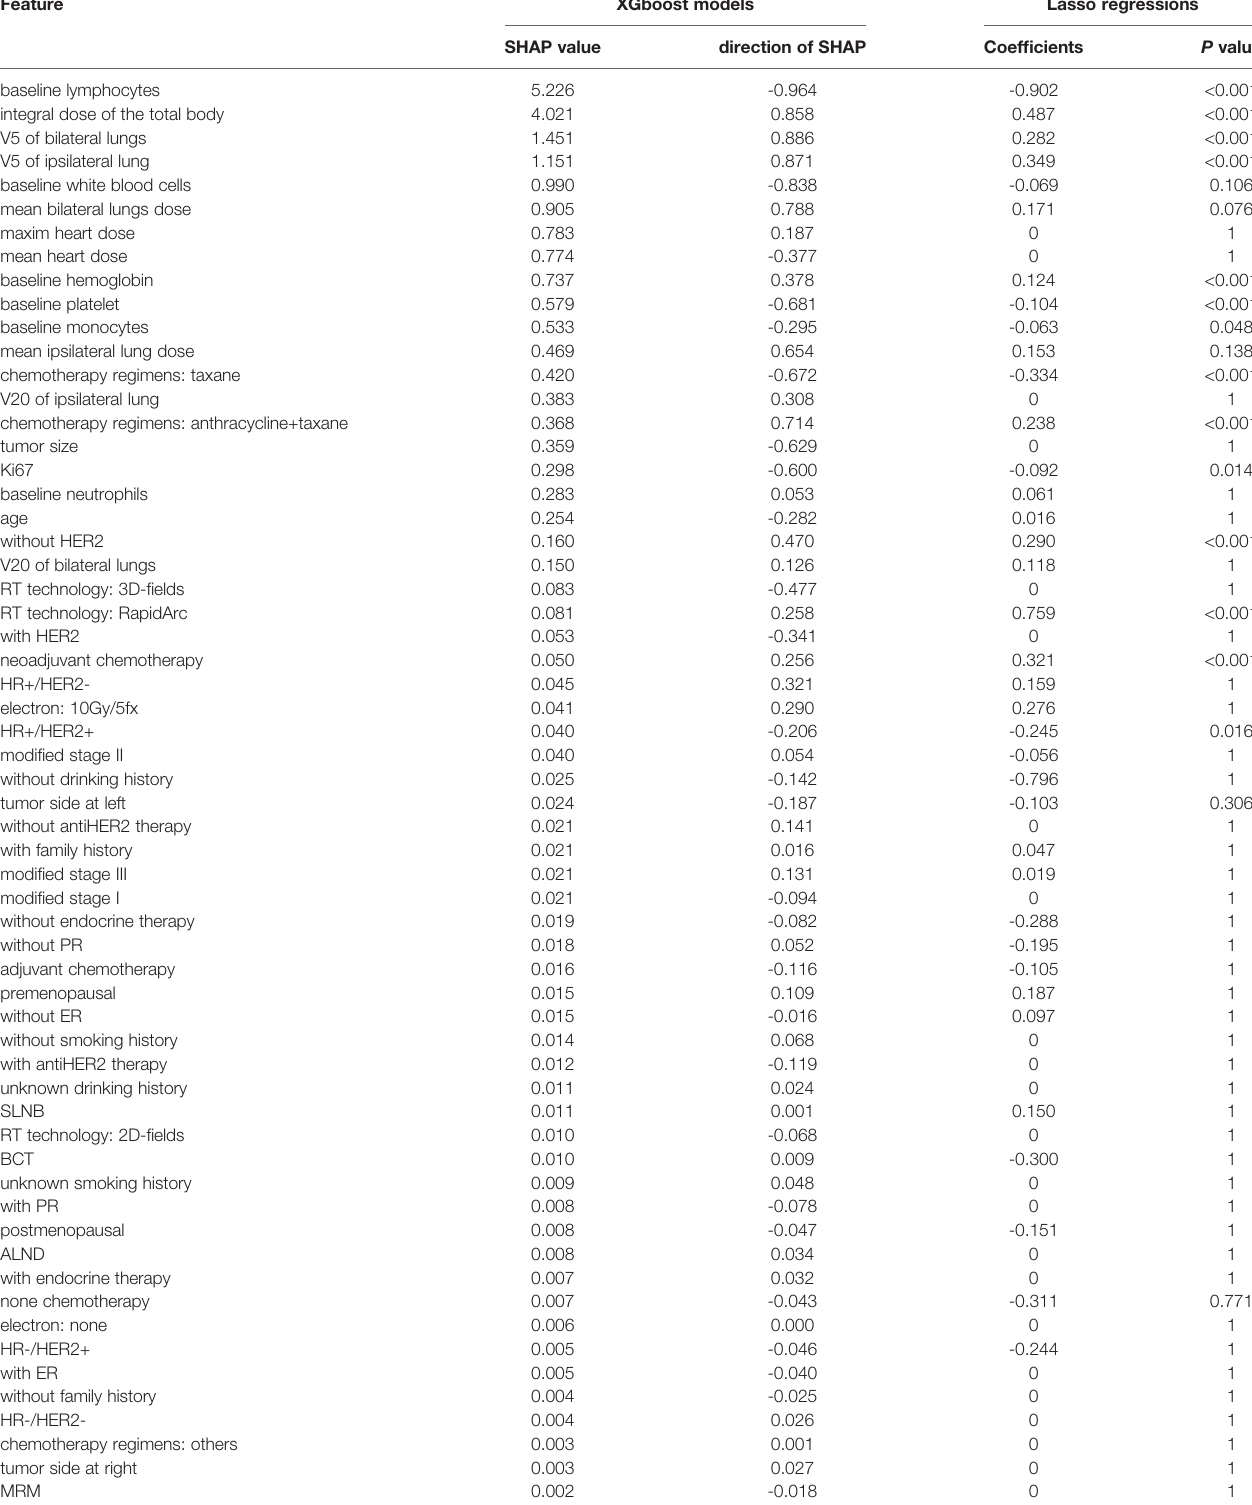
TABLE 2 | The dummy features ’ contributions to lymphopenia in Testing cohort (total 589 patients), including the mean SHAP value and direction of SHAP in XGboost models and the mean coef fi cients in Lasso regression across all